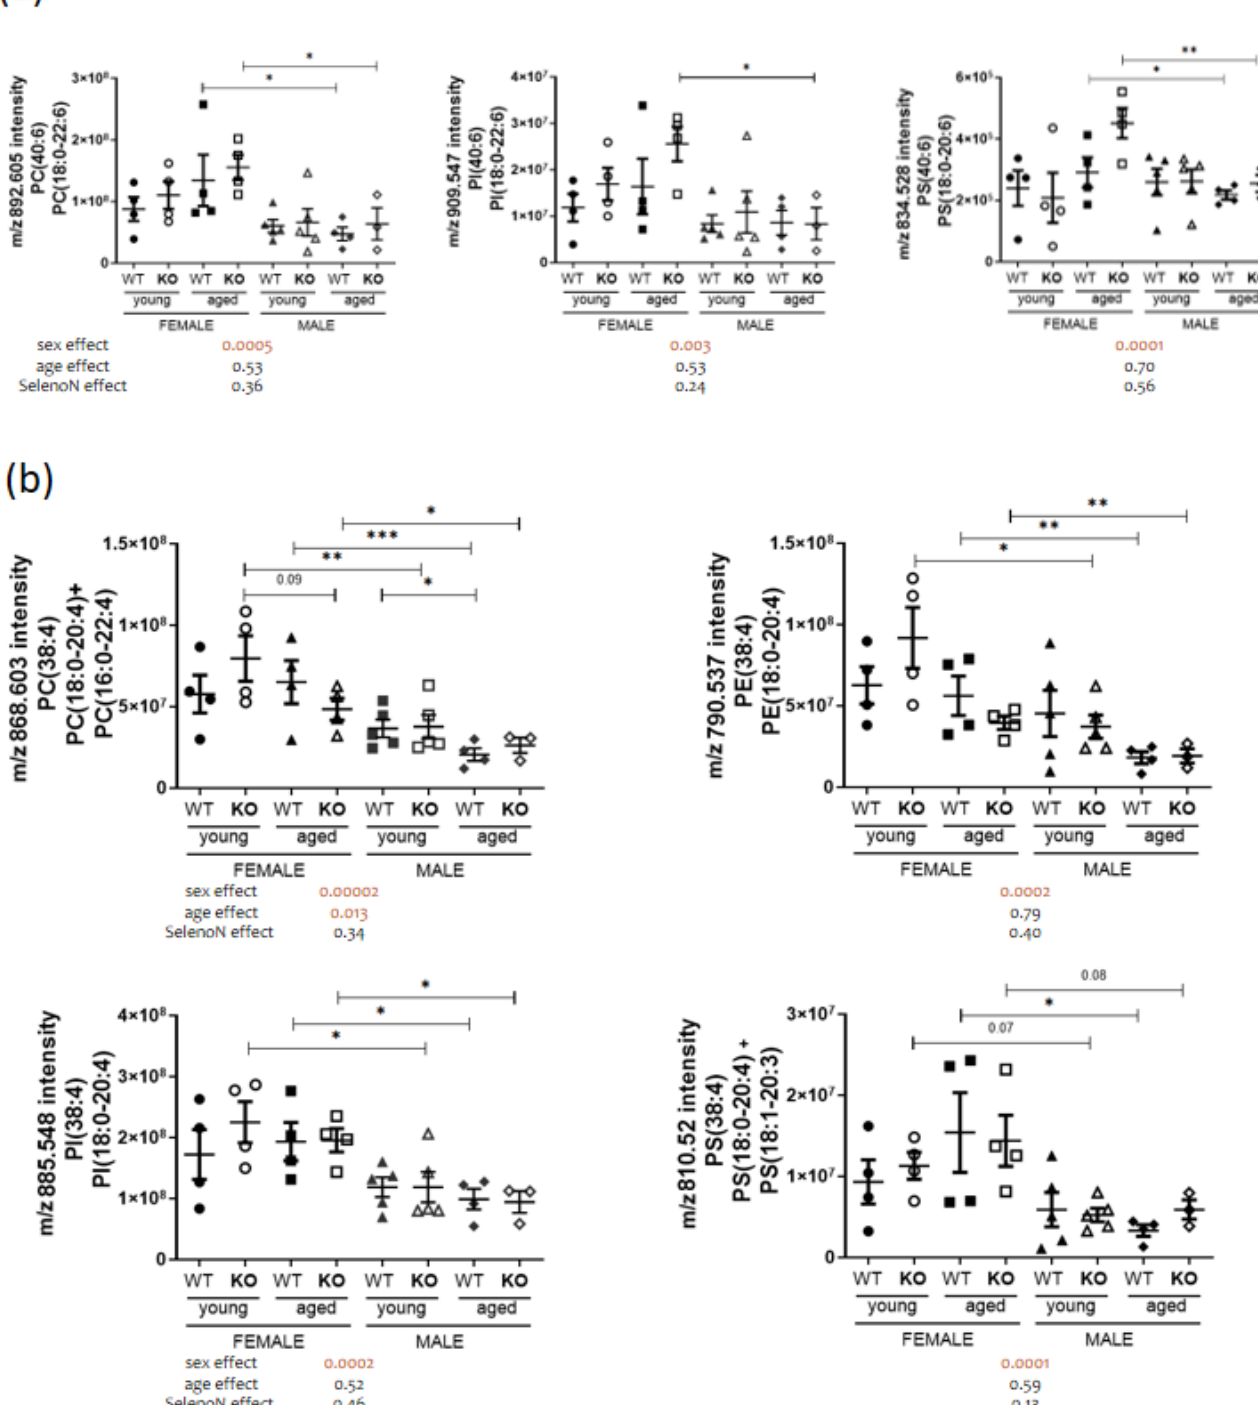
Figure 4. PL containing long fatty acyl chains in diaphragm present sex dimorphism. ( a ) Analysis of m / z intensity of PL (40:6) species (mean ± SEM; n = 4 for each group, except young male WT and KO with n = 5 and aged male KO with n = 3). ( b ) Analysis of m / z intensity of PL (38:4) species. In the graph, p -values are from Tukey’s post hoc tests between pairwise groups. Under the graph, p -values for sex, age and SelenoN effect are defined in Table 2. * p < 0.05, ** p < 0.01 and *** p < 0.001.